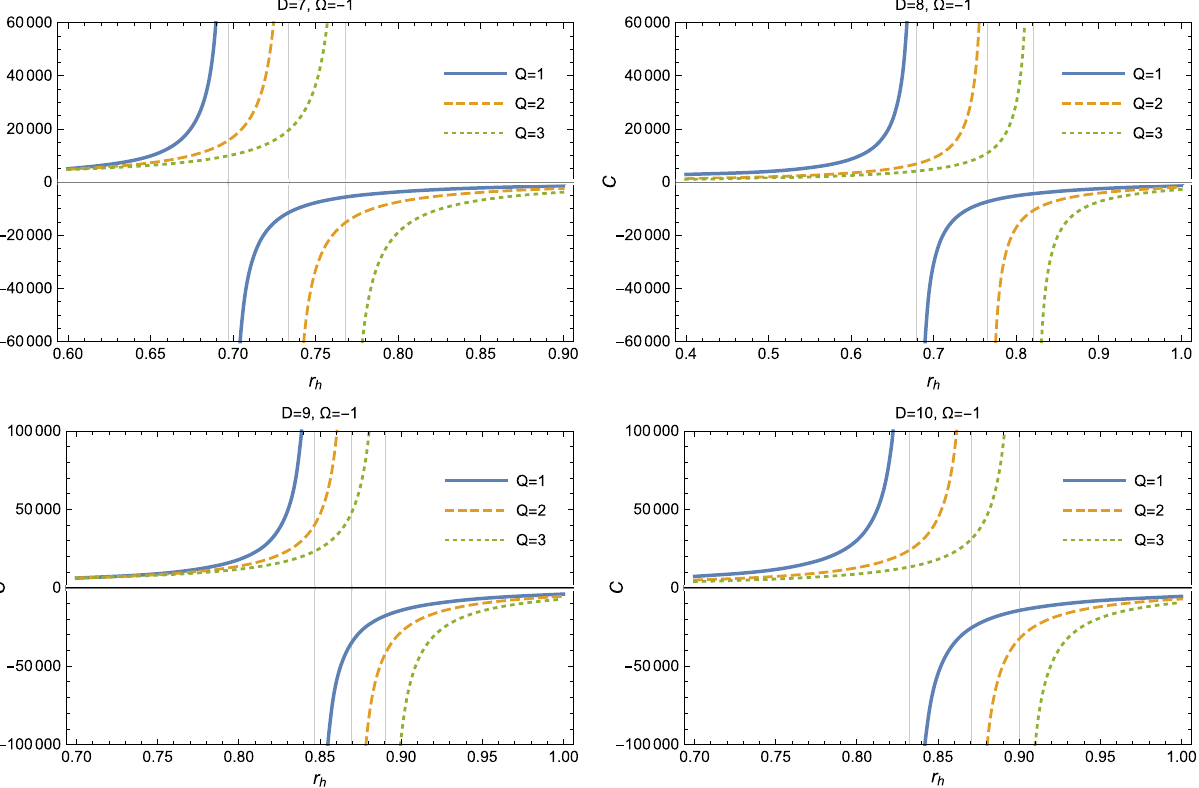
Fig. 3 The plots show how the heat capacity changes with different dimensions. We have chosen the parameters as κ = 1, ˜ α 0 = − 1 and ˜ α = ˜ α = ˜ α = 1 1 2 3 that − 1 ≤ ω q ≤ − 1 /( D − 1 ) . Despite complications